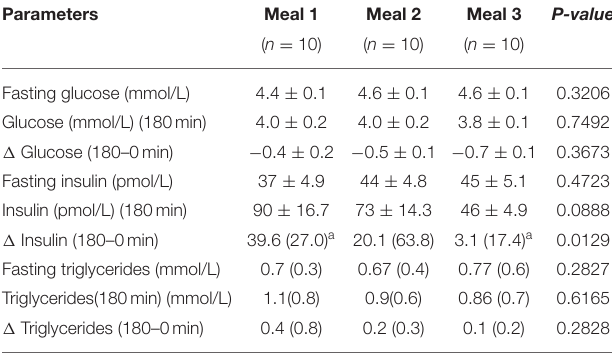
TABLE 3 | Differences in plasma parameters between the meal groups. Parameters